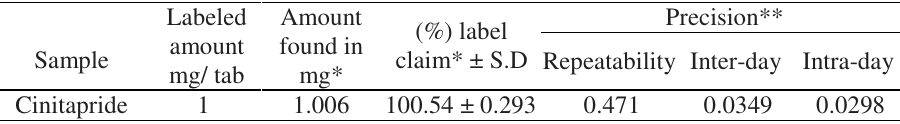
Table 2. Assay results and precision